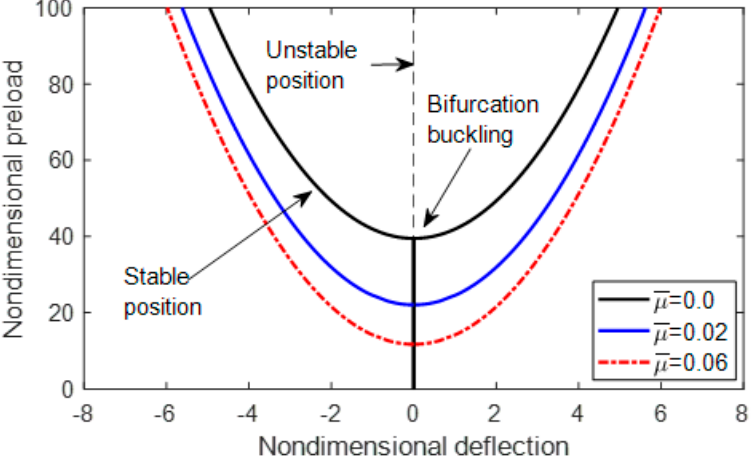
Figure 3. Variation of the buckling amplitude with the axial pre-stress load of a perfect nanobeam with 𝛼 = 1 and a variety of the nonlocal parameter, 𝜇̅.